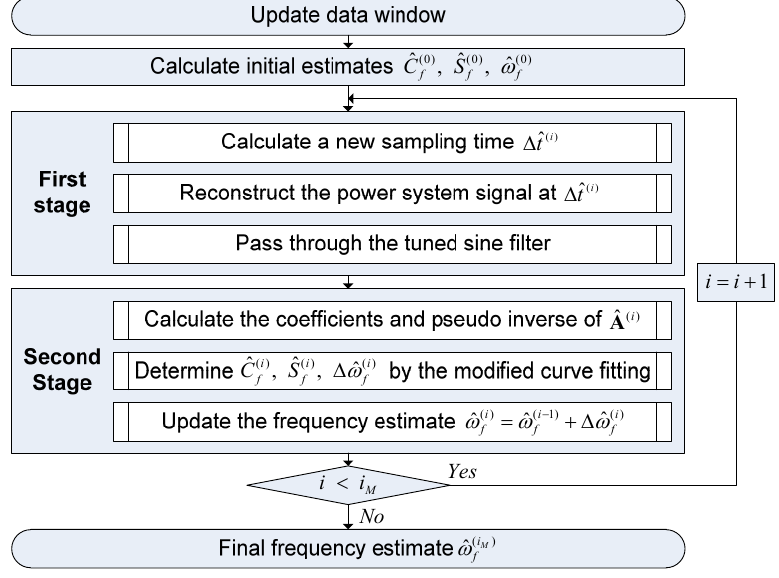
Figure 1. Frequency estimation procedure for the two-stage